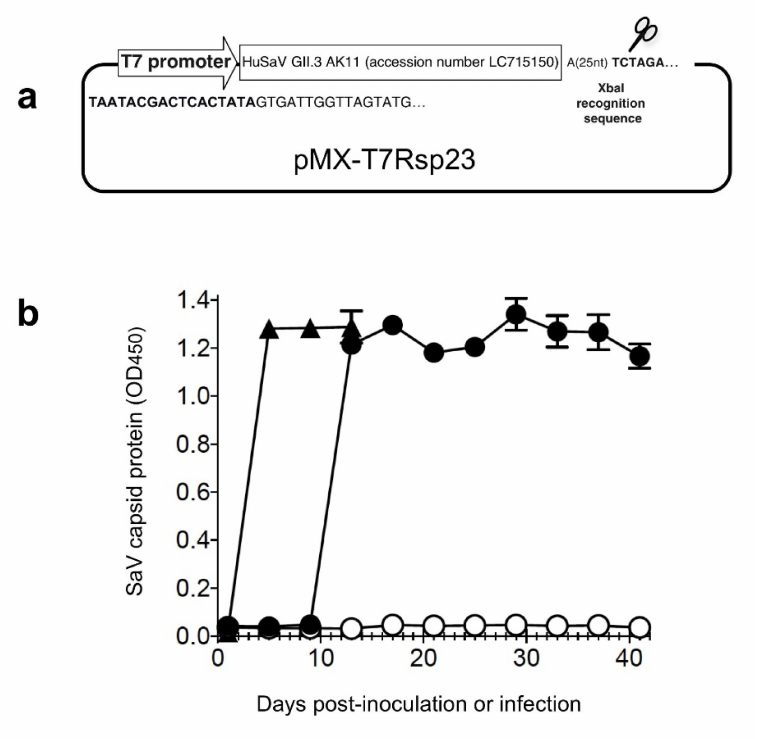
Figure 1. Generation and replication of HuSaV GII.3 AK11 strain in HuTu80 cells. A schematic diagram of the plasmid pMX-T7Rsp23 is shown ( a ). HuTu80 cells were transfected with either capped